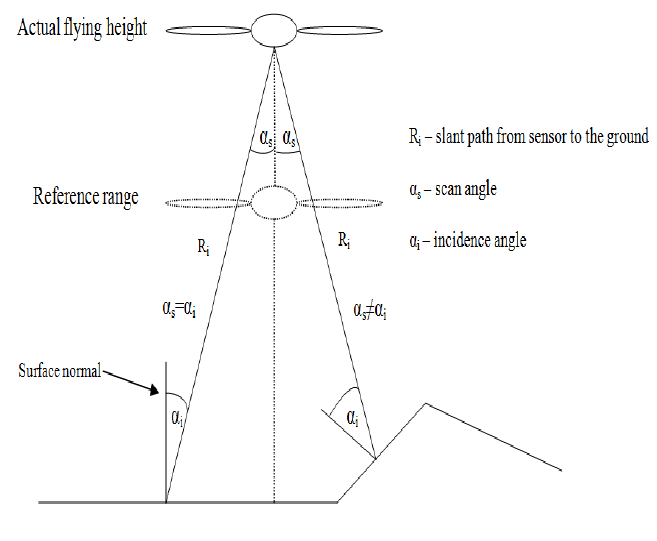
Figure 4. Difference between incidence angle and scan